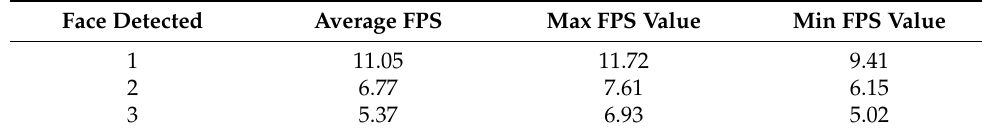
Table 17. System performance in ROS with max_num_faces: 3.